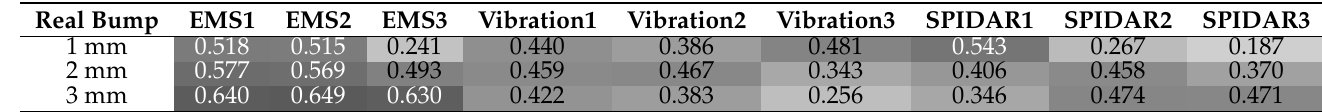
Table 1. Similarity ratios for each method to each real bump. There are three parameters: methods, stimulus intensities, and amplitudes of actual comparative bumps. The first row shows combinations of the methods and stimulus intensities. A numeric value follows after each method name. The numeric value shows the stimulus intensity of each method. The first column shows the amplitudes of the actual bumps. Thus, a total of 27 results are